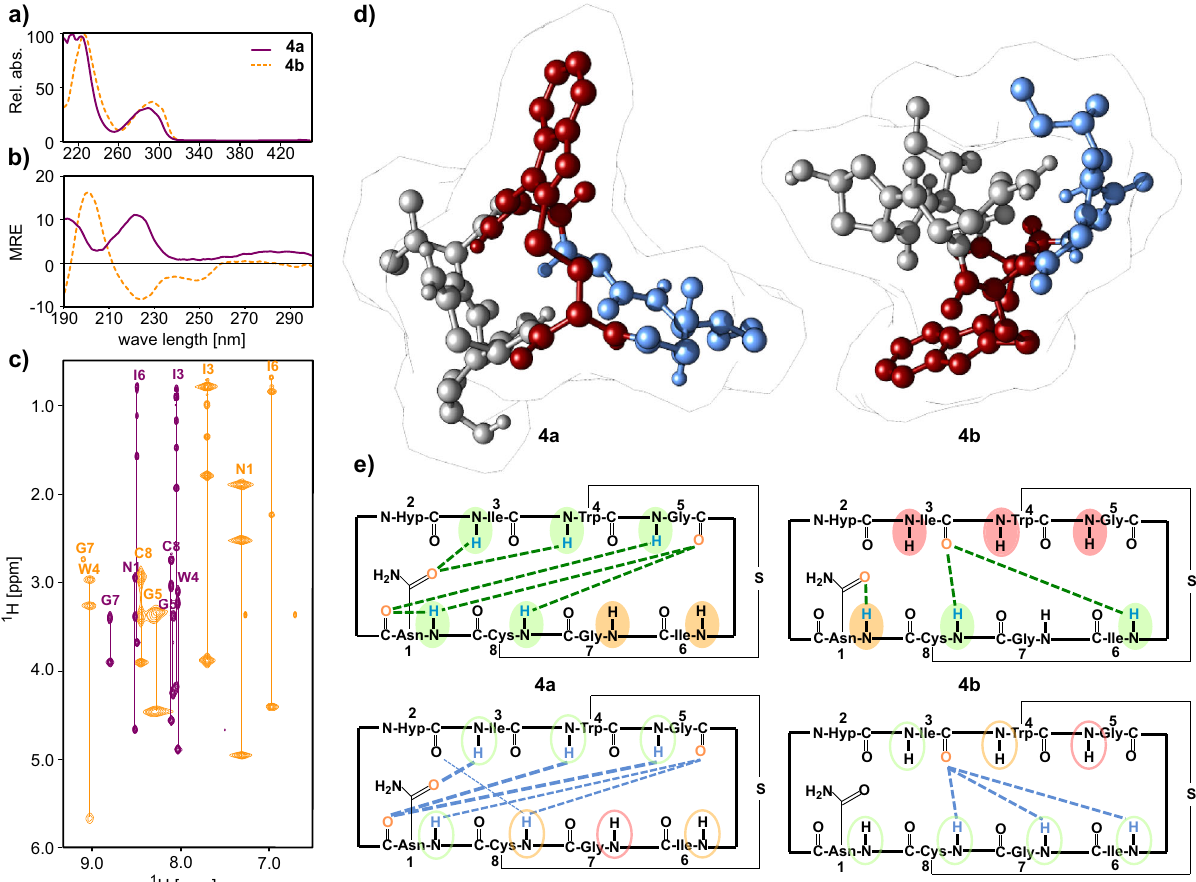
Fig. 3 | Physicochemical differences of amaninamide isomers. UV-absorbance spectra a show different maxima at λ =289nm and 293nm for 4a (purple) and 4b (orange). b CDspectraof 4a (purple)and 4b (orange)showoppositeCottoneffects at225nm. MRE=meanresidue ellipticity in10 3 x [deg*cm 2 *dmol − 1 ]. c Differences in chemical shifts of 4a (purple) and 4b (orange) in the amide region of the 1 H- 1 H-TOCSY NMR spectra. d Crystal structures of 4a 15 and 4b . The A-ring and B-ring are colored gray and blue, respectively. The tryptathionine bridge is shown in red. e H-bondsfoundinthecrystalstructuresof 4a (left)and 4b (right)areindicatedby dashed green lines (top schematics). Amides with small chemical shift changes in VT-NMR measurements ( Δδ HN/ Δ T> − 3.0ppbK-1) indicative of H bonding are